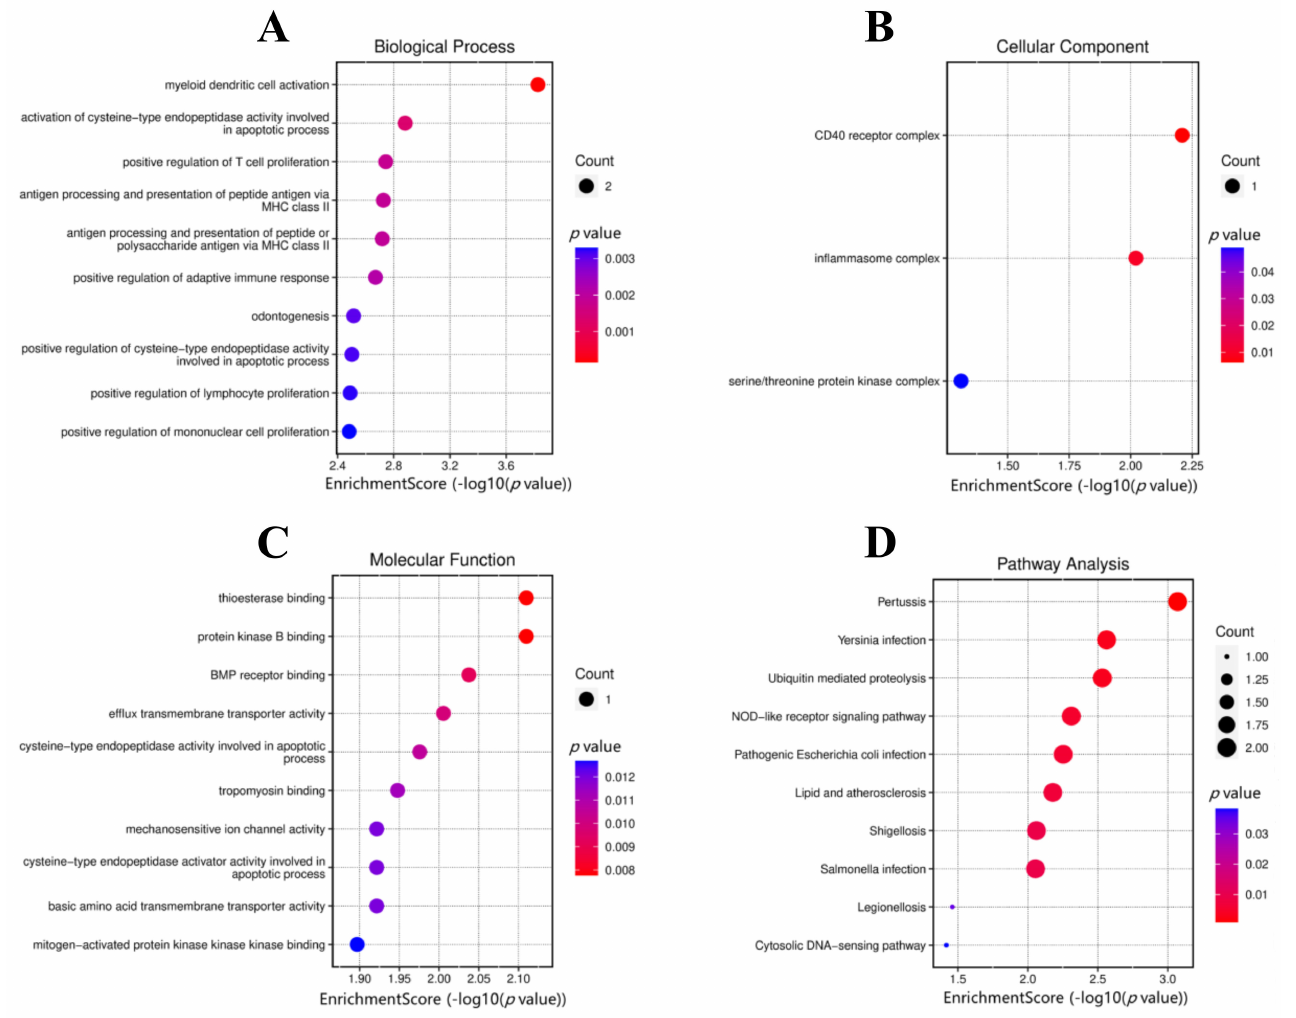
Figure 3. Functional enrichment analysis of target genes. ( A ) BP; ( B ) CC; ( C ) MF; ( D ) KEGG enrichment pathways of